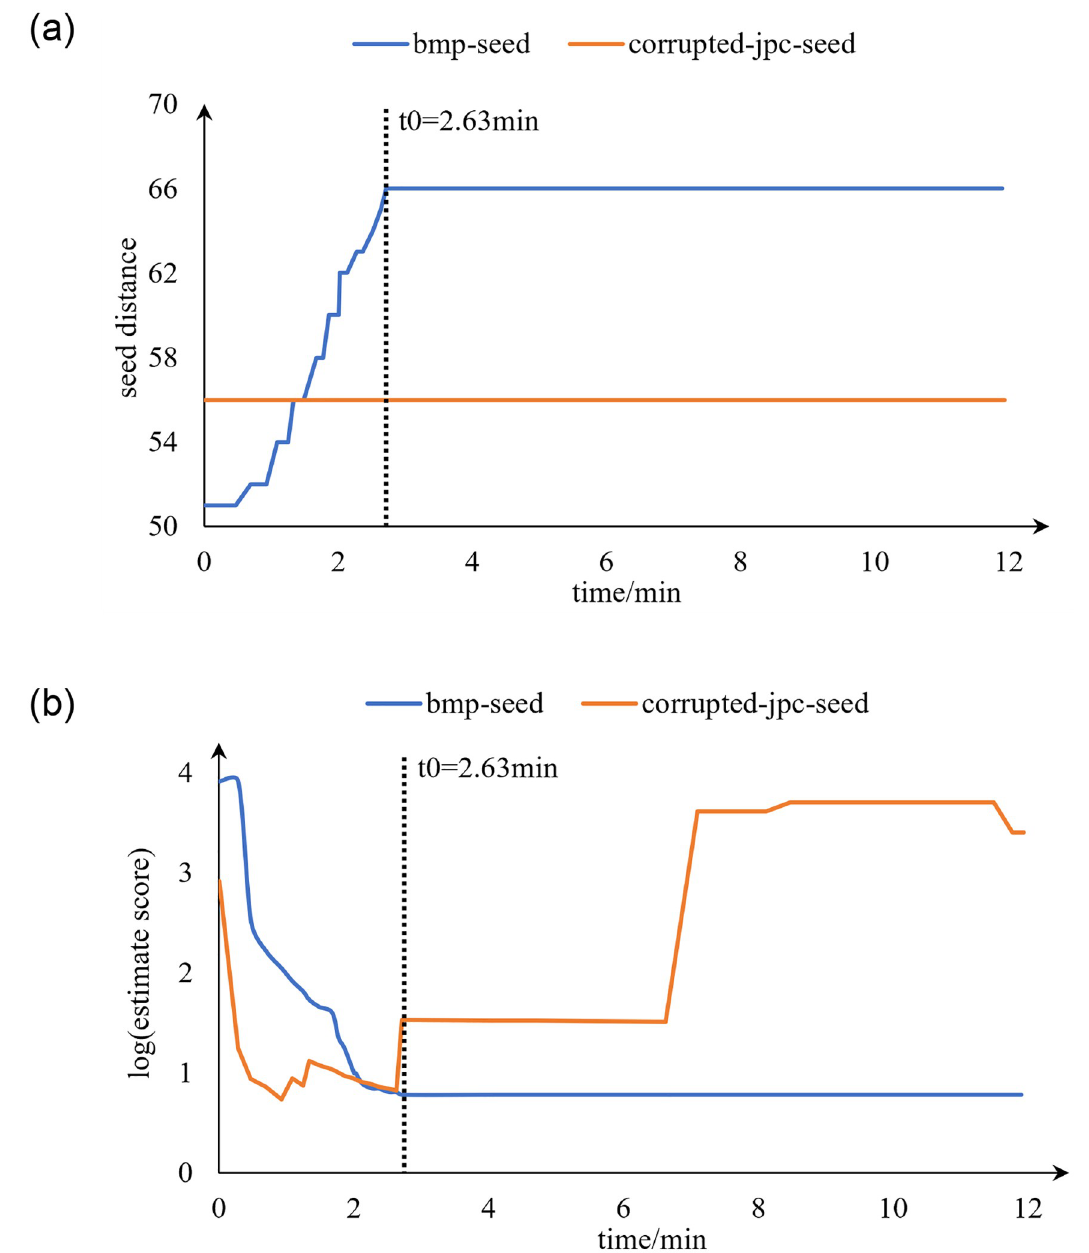
Fig 7. Seed distance and estimated score of two unique seeds in RLTG.